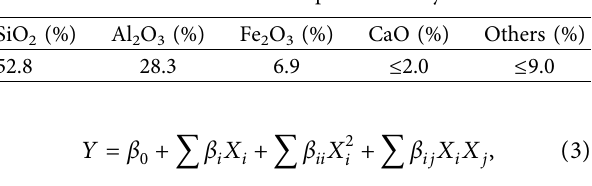
Table 3: Chemical components of MgCl